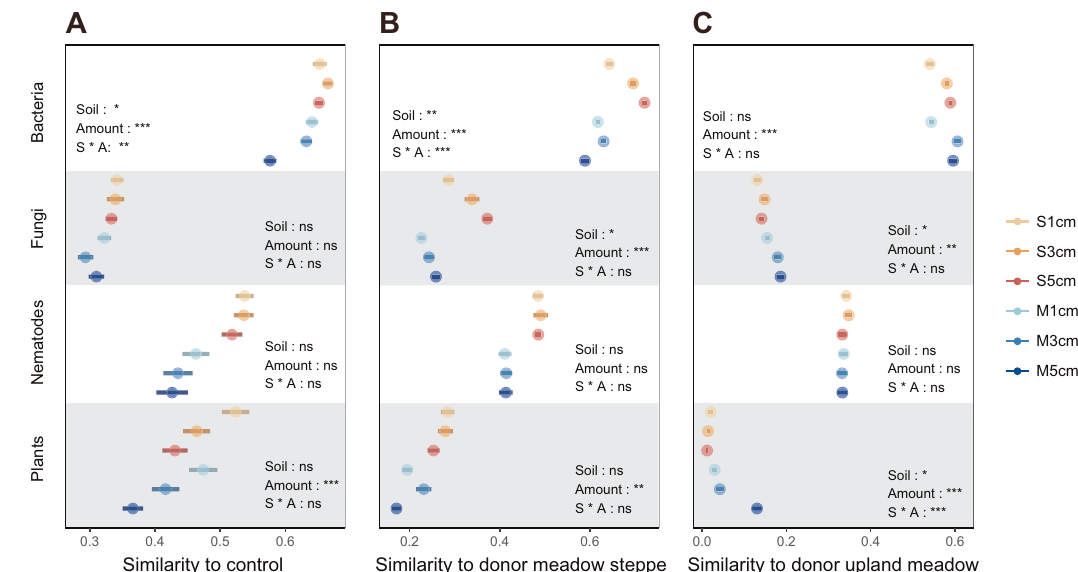
Fig. 4 Similarity of soil biotic and plant communities to control and donor sites. Similarity between soil inoculation treatments to control ( A ) or donor treatments ( B , C ). Error bars represent ±S.E. The category de fi nitions are as follows: S1cm, meadow steppe soil inoculation with 1 cm depth; S3cm, meadow steppe soil inoculation with 3 cm depth; S5cm, meadow steppe soil inoculation with 5 cm depth; M1cm, upland meadow soil inoculation with 1 cm depth; M3cm, upland meadow soil inoculation with 3 cm depth; M5cm, upland meadow soil inoculation with 5 cm depth. * P < 0.05; ** P < 0.01; *** P <